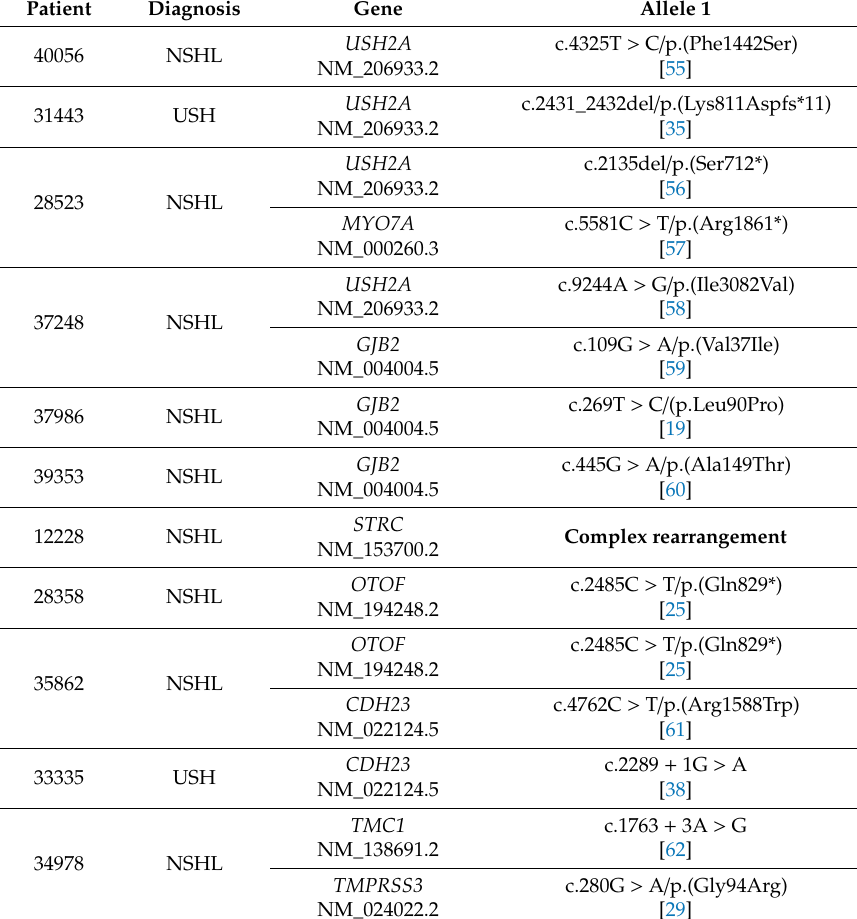
Table 4. Patients with only One Heterozygous Pathogenic or Likely Pathogenic Variant in Genes Associated with an Autosomal Recessive Inheritance